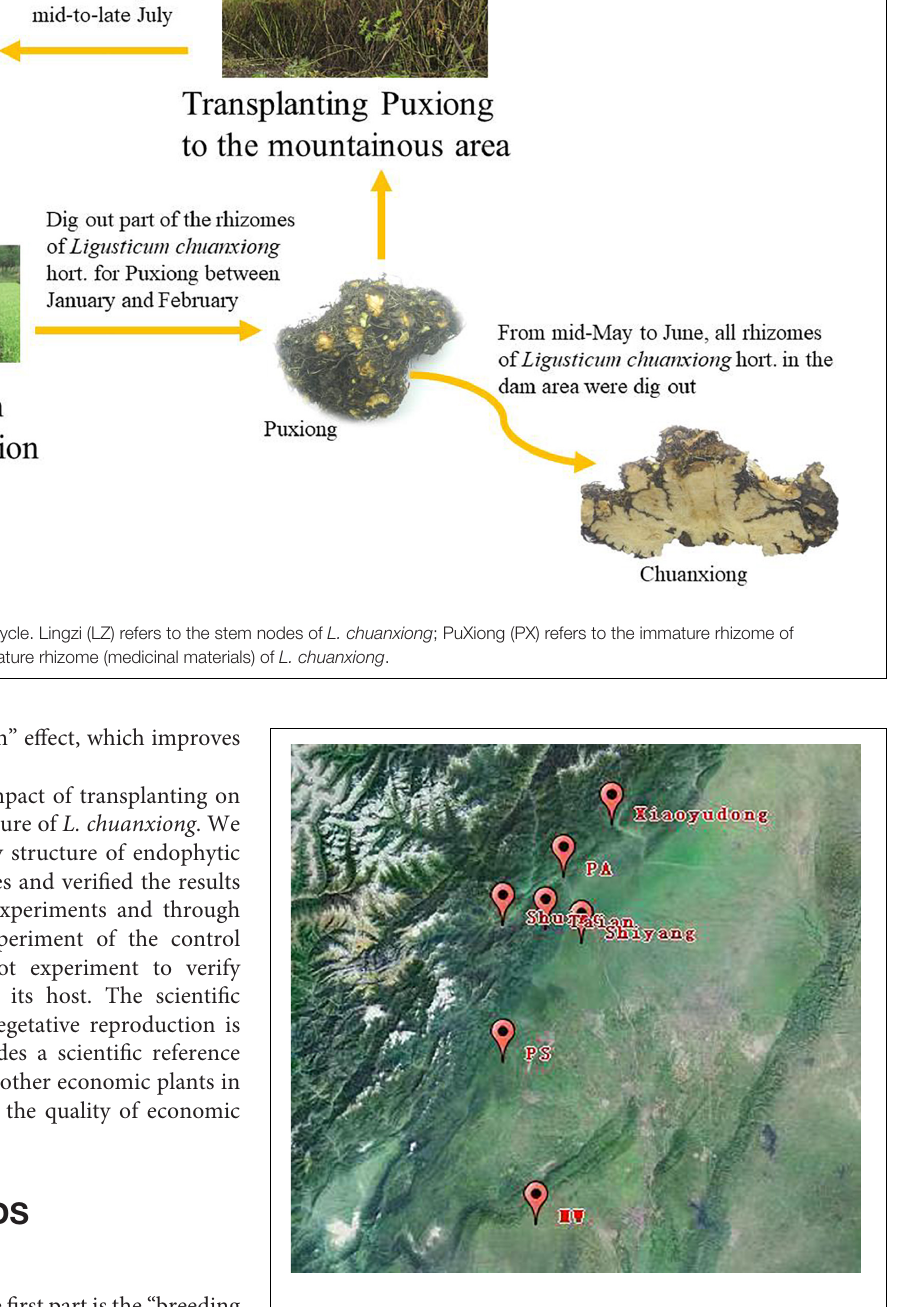
FIGURE 2 | Location map of the study